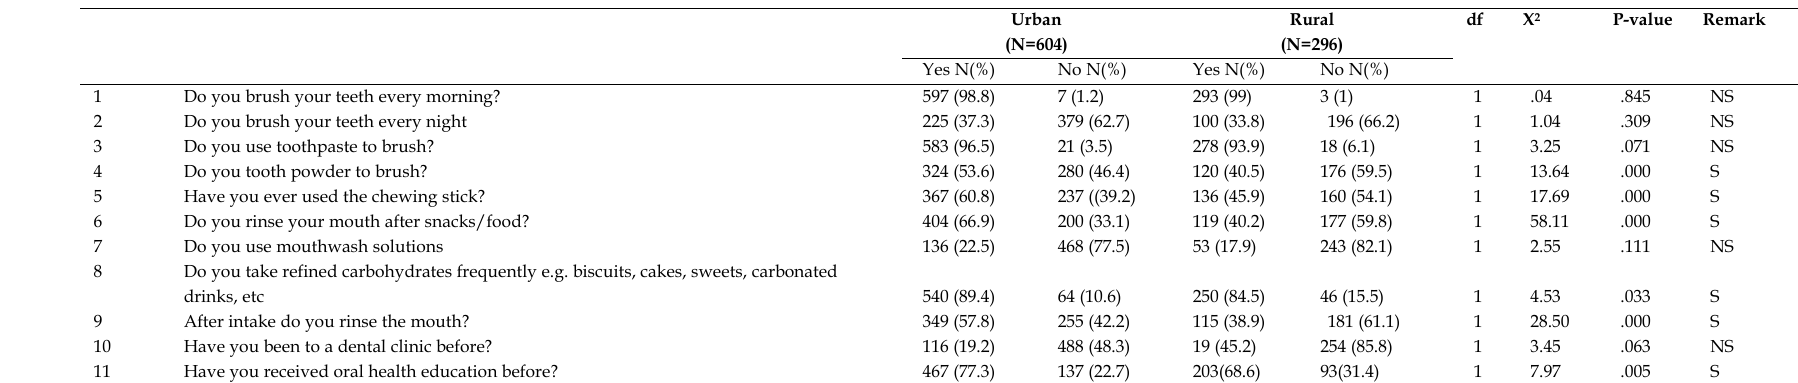
Table 2: Chi-square analysis on the difference in the preventive measures adopted by the Senior Secondary School students based on school location